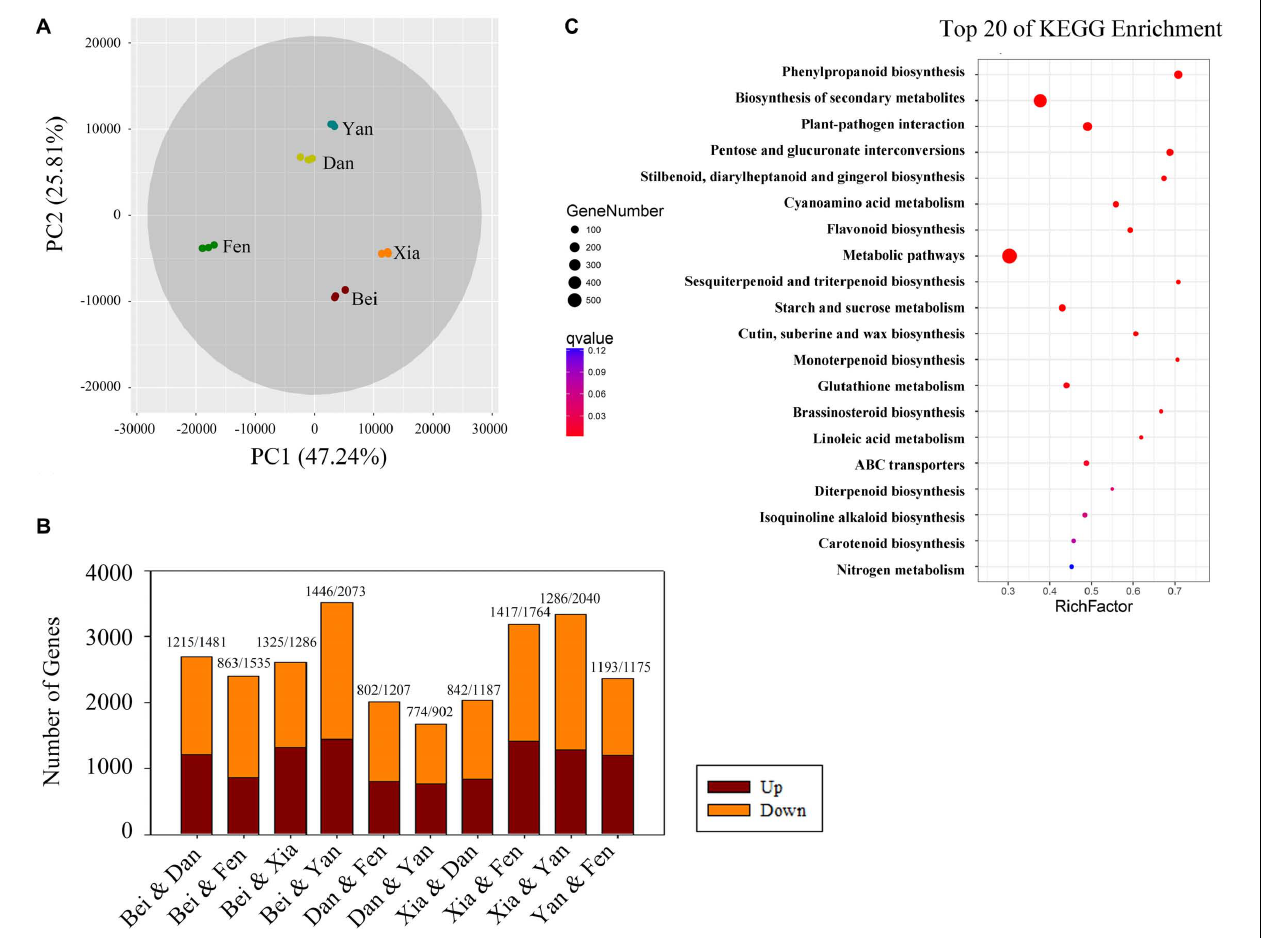
FIGURE 4 | Bioinformatics analysis of differentially expressed genes in the transcriptomes of the five varieties. (A) PCA score plot for the five varieties. (B) Numbers of differentially expressed genes (genes with a fold change > 4) between each pair of varieties. The numbers of upregulated and downregulated genes are shown above the columns. (C) Top 20 pathways in the KEGG enrichment analysis. The number of genes in each category is equal to the point size. The point color represents the q -Value.